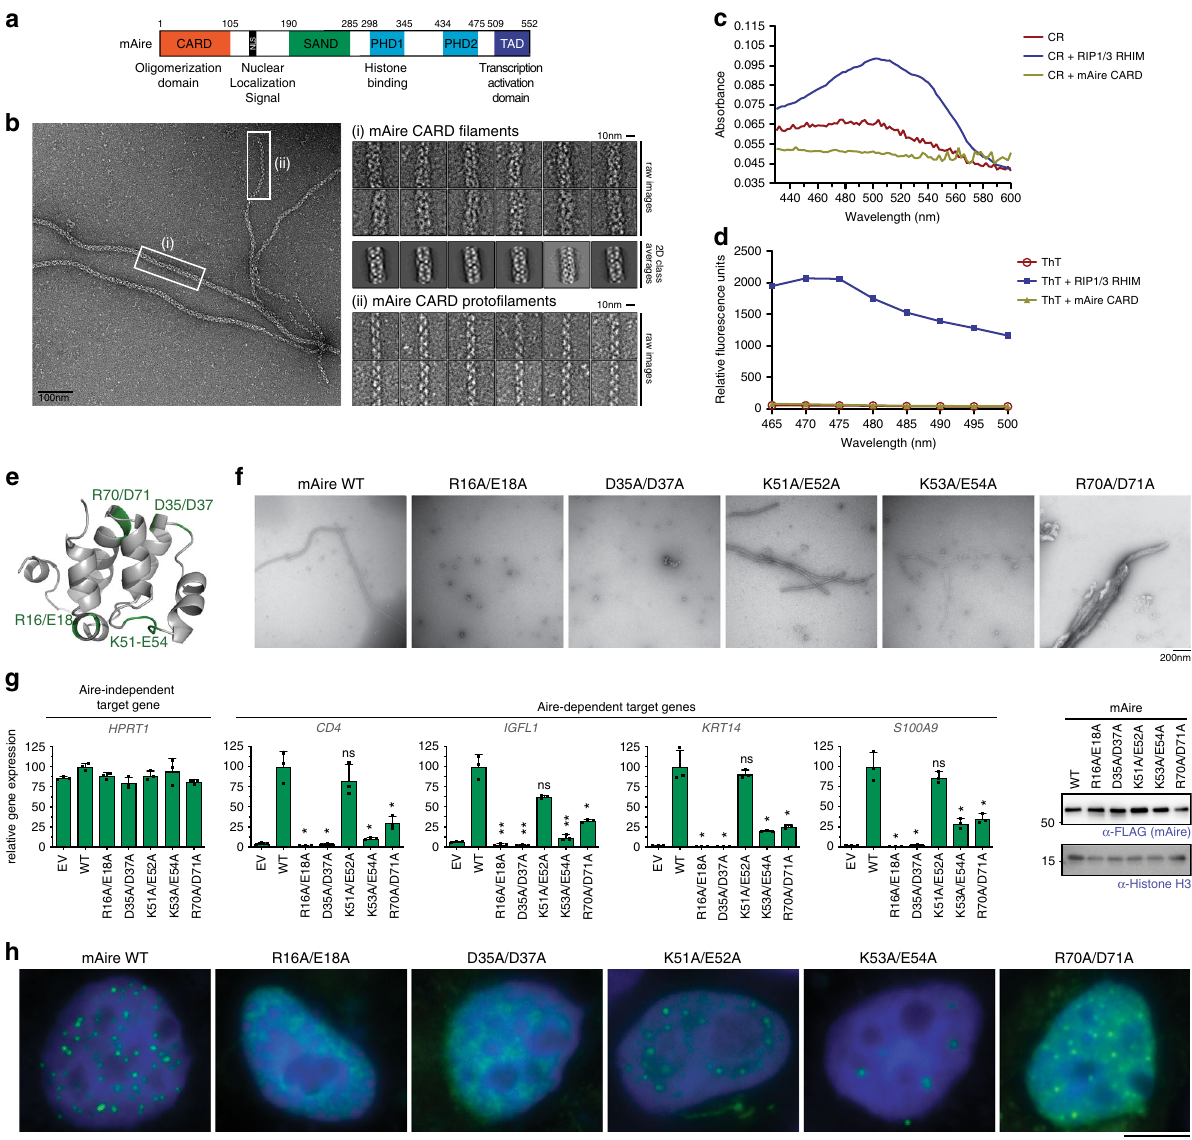
Fig. 1 Filament assembly of Aire CARD mediates nuclear foci formation and transcriptional activity. a Schematic of murine Aire domain architecture with previously characterized functions of individual domains. b Representative EM image of wild-type (WT) mAire CARD. While fully formed CARD fi laments (i) were major species, thin proto fi laments (ii) were also observed. Right, representative images of the two types of fi laments. 2D class averages were also shown for fully formed CARD fi laments. c , d Representative absorption spectra of Congo Red (CR, 15 μ M) ( c ) or fl uorescence emission spectra (excitation at 430 nm) of Thio fl avin (ThT, 50 μ M) ( d ) in the presence of WT mAire CARD fi laments or known amyloids of RIP1/3-RHIM 70 . 5 μ M monomeric concentration was used for both proteins. The experiments were performed two independent times. e 3D homology model of mAire CARD using the program FUGUE 2.01. Putative CARD:CARD interfaces were identi fi ed from the sequence alignment with other CARDs (Supplementary Fig. 1a) and are highlighted green. f Representative EM images of recombinant mAire CARD. WT protein and those with mutations in the putative CARD:CARD interfaces in ( e ) were compared. g Transcriptional activity of WT mAire and mutants, as measured by the relative mRNA levels of Aire-dependent genes (represented by CD4 , IGFL1 , KRT14 and S100A9 ). An Aire-independent gene, HPRT1 , was also examined as a negative control. Aire variants were transiently expressed (using 1.25 μ g/ml DNA) in 293 T cells for 48 h prior to RT-qPCR analysis. Data are representative of at least three independent experiments and presented as mean ± s.d., n = 3. Right, western blot (WB) showing the expression levels of FLAG-tagged mAire compared to endogenous levels of Histone H3 (anti-H3). See Supplementary Fig. 1c for experiments in 4D6. P -values (two-tailed t -test) were calculated in comparison to WT mAire. * p < 0.05; ** p < 0.01; p > 0.05 is not signi fi cant (ns). Exact p -values are provided in the Source Data File. h Representative fl uorescence images of FLAG-tagged mAire in 293 T cells using anti-FLAG. See Supplementary Fig. 1d for experiments in (Fig. 1f), could still form nuclear foci, but had low transcriptional K83E 38,39 (Supplementary Fig. 1a). As with mAire CARD, we activity (Fig. 1g, h and Supplementary Fig. 1c, d). puri fi ed hAire CARD variants from E. coli , although puri fi cation To further test the importance of Aire CARD fi lament required a refolding step (Supplementary Fig. 1e). We found that formation, we examined human Aire (hAire) CARD and fi ve WT hAire CARD also forms fi laments (Supplementary Fig. 1f). variants with APS-1 mutations L13P, T16M, L28P, A58V, and Under the same refolding condition, all fi ve APS-1 mutants did